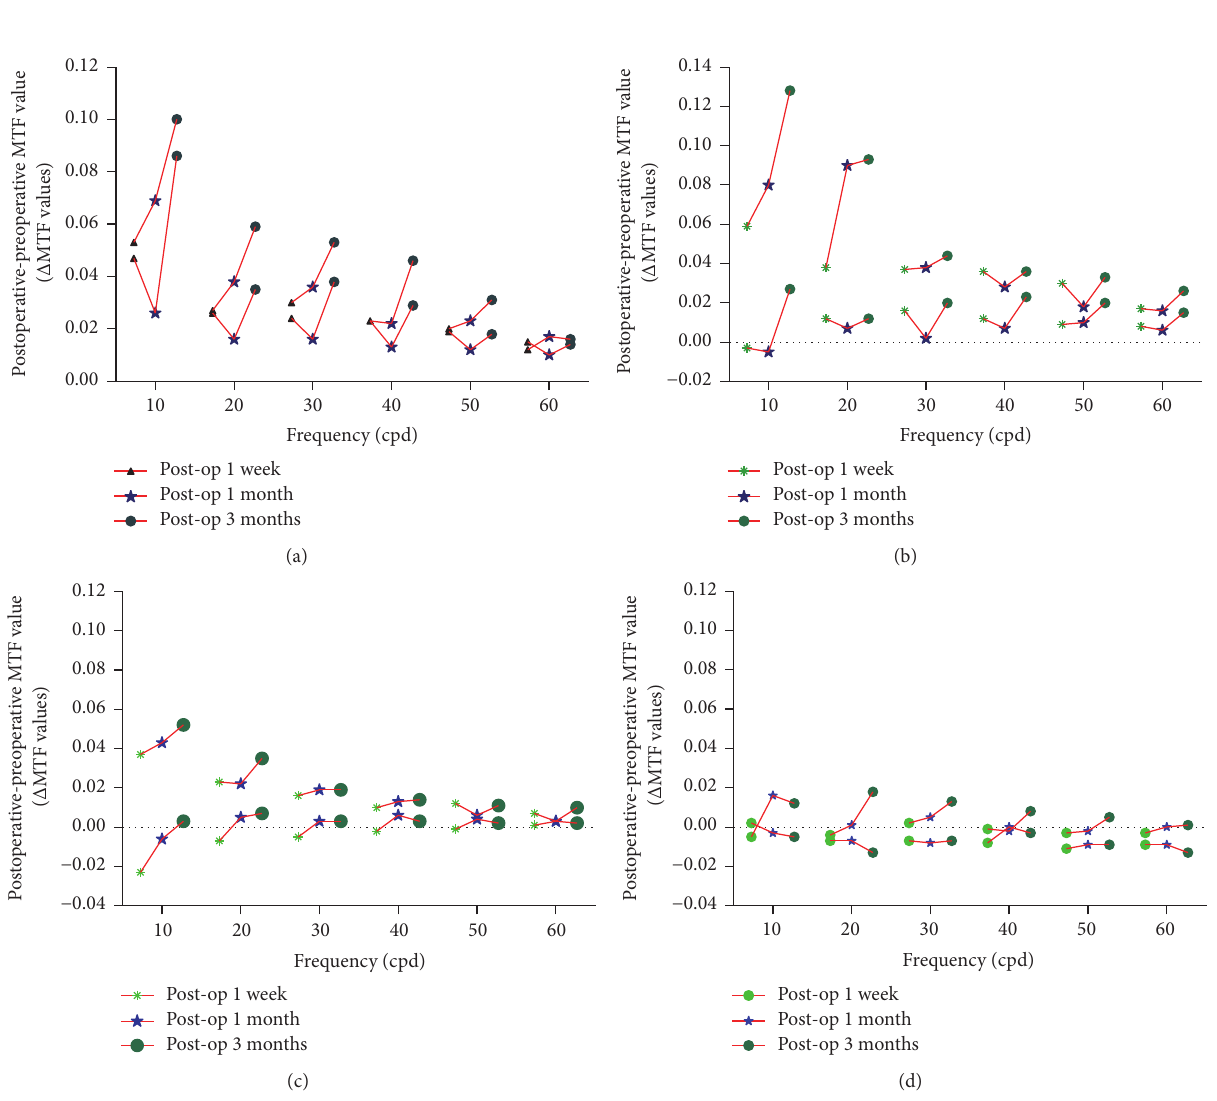
Figure 3: The changes in Δ MTF values (postoperative-preoperative MTF value) between SMILE and Femto-LASIK procedures at 1 week, 1 month, and 3 months postoperatively (up broken lines: Changes of MTF values at 1 week, 1 month, and 3 months after SMILE procedure at different spatial frequency; lower broken lines: changes of MTF values at 1 week, 1 month, and 3 months after Femto-LASIK procedure at different spatial frequency). (a) The change of MTF at vertical meridian at 3 mm pupil diameters; (b) the change of MTF at horizontal meridian at 3 mm pupil diameters; (c) the change of MTF at vertical meridian at 6 mm pupil diameters; (d) the change of MTF at horizontal meridian at 6 mm pupil diameters.